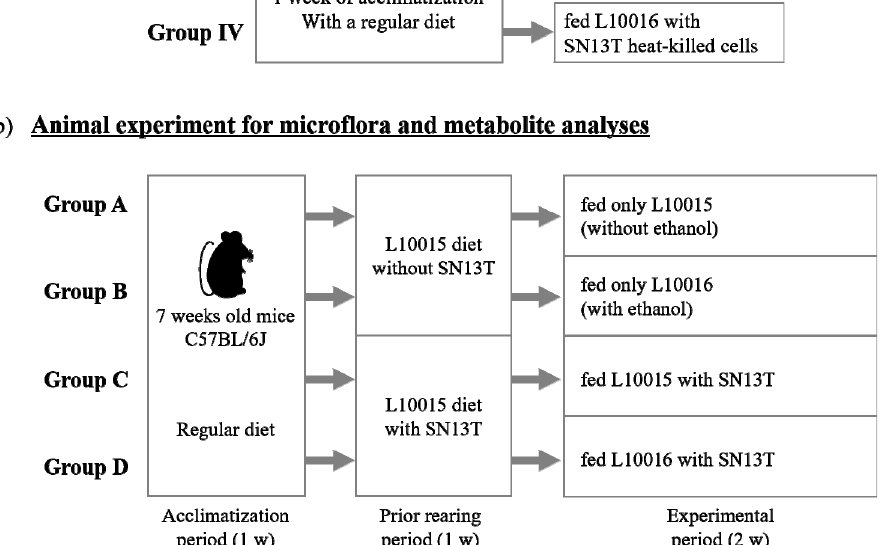
Figure 6. The outlines of animal experiments for survival analysis ( a ) and microbiota and metabolite analyses ( b ).